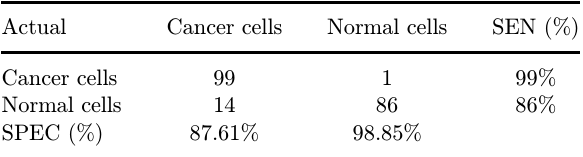
Table 1. Classi¯cation results obtained using SVM model.